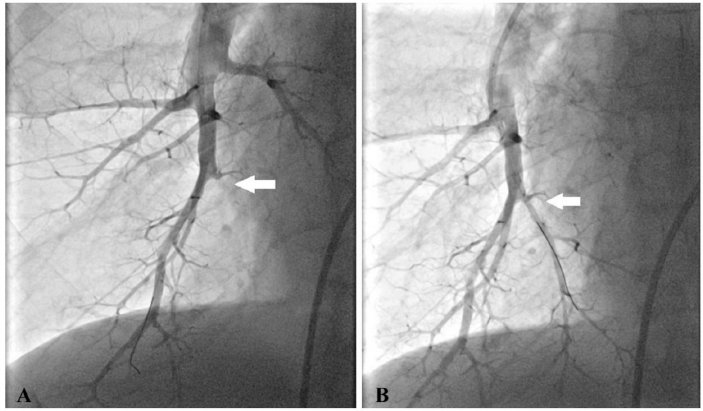
Figure 1. Selective pulmonary angiogram of the right lower lobe shows total occlusion of segmental branch A10 ( A ) and its opening after the first BPA procedure ( B